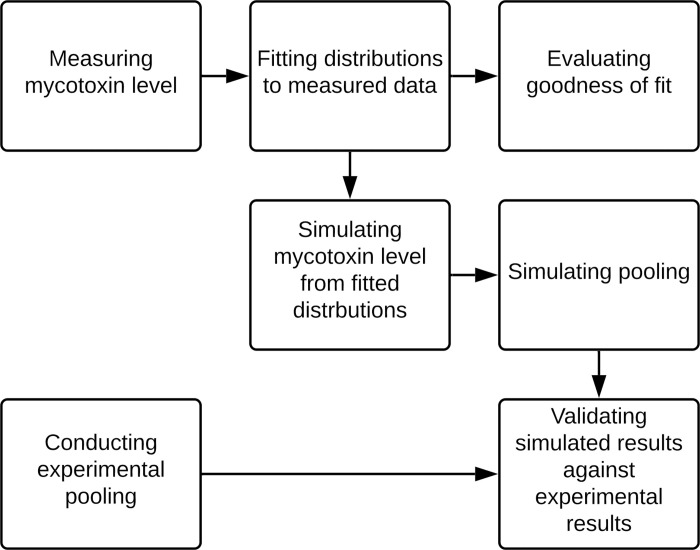
Flow chart of the overall study design.